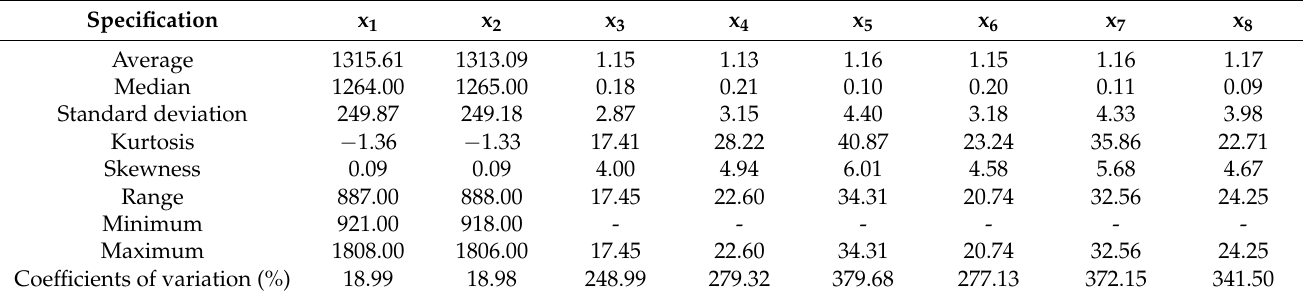
Table 2. Descriptive statistics for the characteristics of essential oils of Thymus